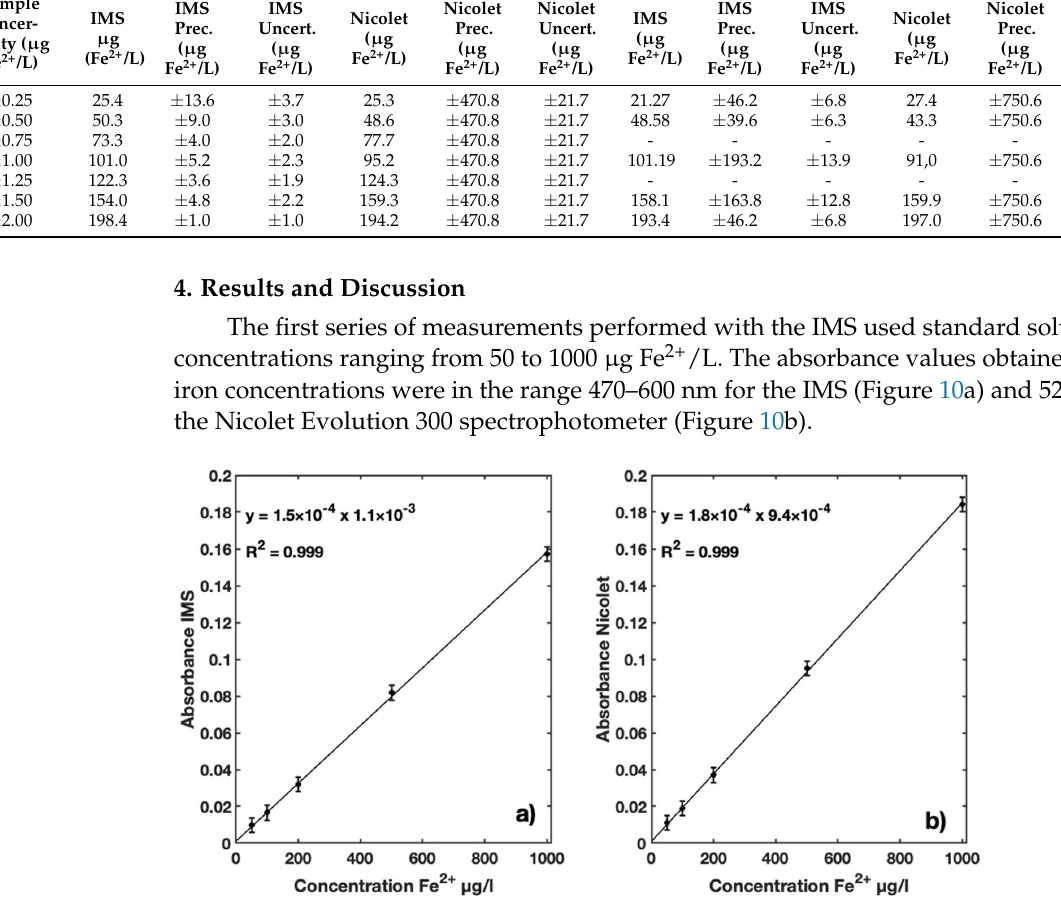
Figure 10. ( a ) Calibration function for Fe 2+ ranging from 50 to 1000 µg/L using IMS instrument, with integration wavelengths between 470 and 600 nm; ( b ) calibration function for Fe 2+ ranging from 50 to 1000 µg/L using Nicolet Evolution 300 spectrophotometer absorption coefficients at 525 nm. For both instruments, the absorbance was found to vary linearly with increasing iron concentration in the standard solutions. Both instruments presented R 2 = 0.999, indicating a good correlation between Fe 2+ concentration and measured absorbance. The slope of linear regression for the IMS is 1.5 × 10 −4 with an intercept of 1.1 × 10 −3 , while the slope for the Nicolet Evolution 300 is 1.8 × 10 −4 with an intercept of 9.4 × 10 −4 . The agreement in measurements between the two instruments can be seen in the graph of Figure 11. A Pearson coefficient correlation of 1 with a p -value of 1.37 × 10 −10 was found for the linear relation between the IMS and the reference instrument, with a coefficient of determination R 2 = 1. Magnified views of the absorbances of 50, 100, 200, 500, and 1000 µg Fe 2+ /L are presented in order to compare the uncertainty of both measurements (Figure 11). The results allow us to conclude that the uncertainty of the IMS is significantly smaller than that of the spectrophotometer.